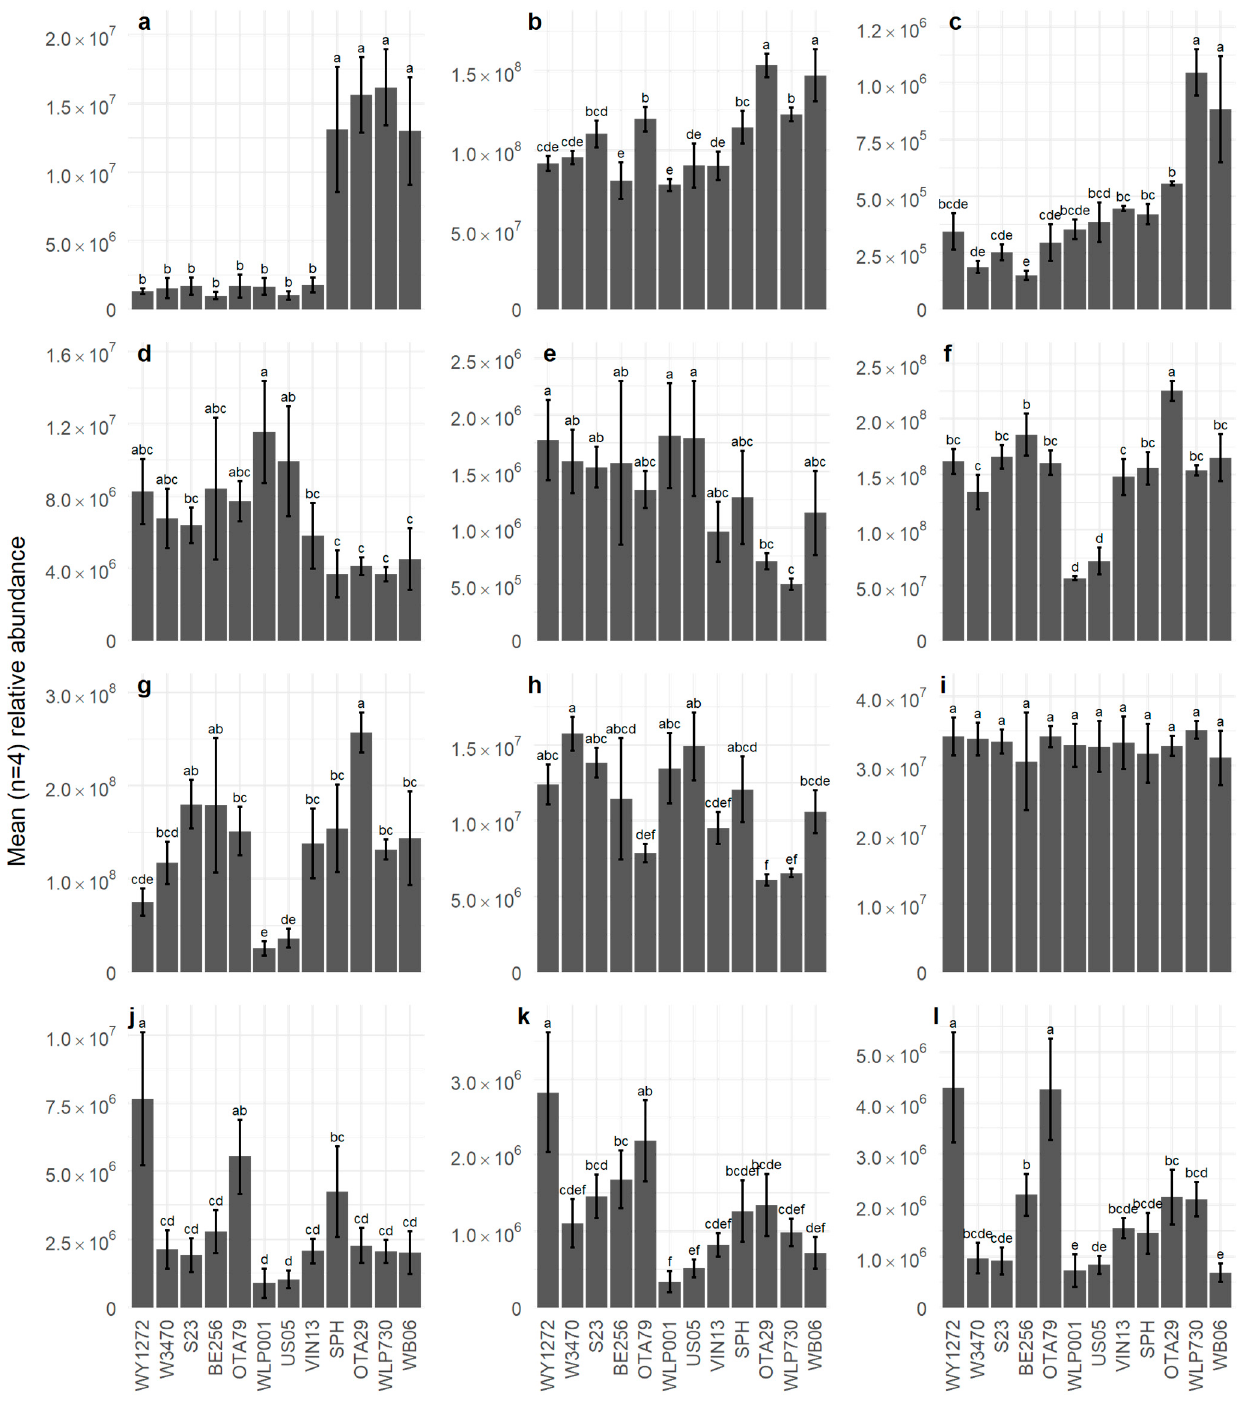
Figure 3. Relative abundance (deconvoluted peak area) of VOC in twelve beer samples. ( a ) 4-vinylguaiacol, ( b ) ethyl hexanoate, ( c ) dimethyl sulfide, ( d ) geraniol, ( e ) nerol, ( f ) isoamyl acetate, ( g ) 2-phenylethyl acetate, ( h ) citronellol, ( i ) linalool, ( j ) citronellol acetate, ( k ) nerol acetate, and ( l ) geranyl acetate. Values are plotted as means ± standard deviation. In each graph, samples sharing the same letter are not significantly different at p < 0.05. Note the different y-axis values.